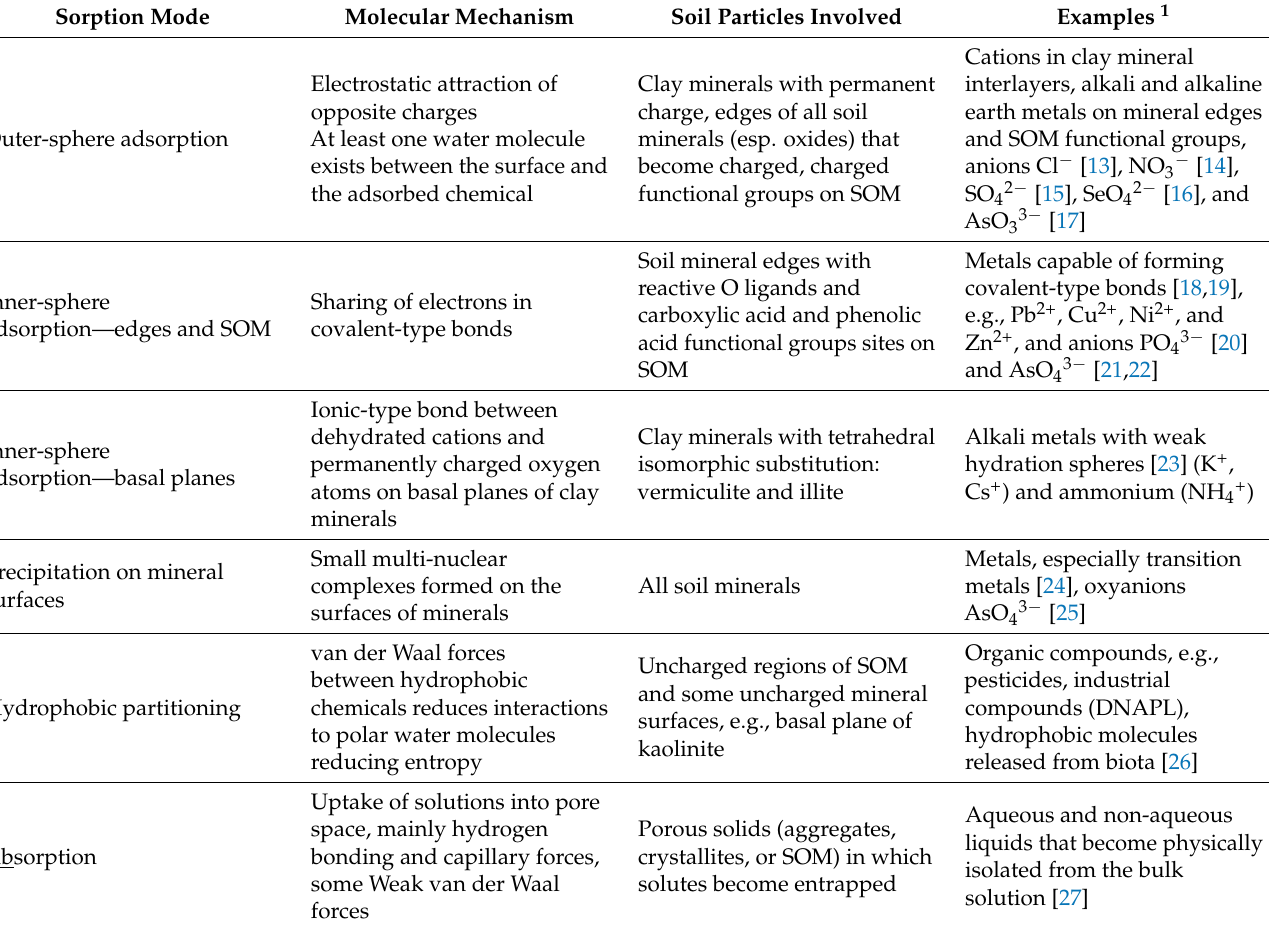
Figure 1. Illustration showing examples of ion adsorption as inner- and outer-sphere complexes on a mineral surface. Ions in the diffuse-double layer are hydrated (water molecules not shown). Surface charge components ( σ ) are shown (see Table 3). Adapted from Strawn et al. [28] with permission. Table 1. Sorption mechanisms that occur on soil